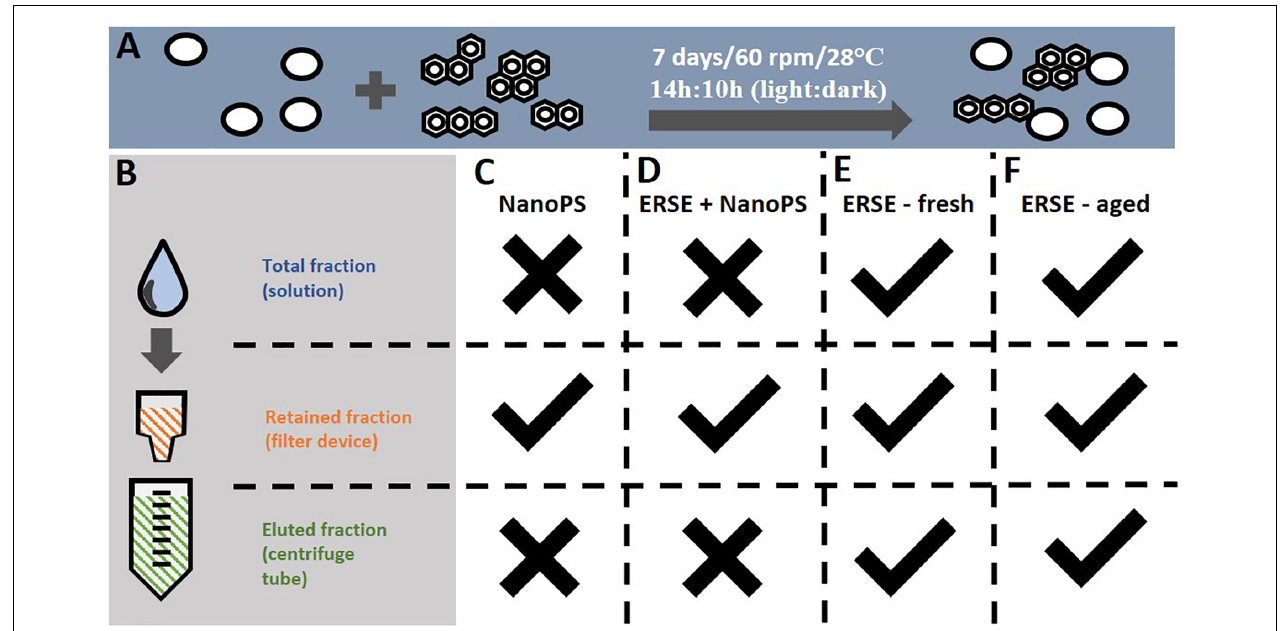
FIGURE 1 | Procedures for the sorption of PAHs to nanoplastics and the exposure groups analyzed in this study. (A) Polystyrene nanoparticles (44 nm) were incubated at 10 ppm with a mixture of PAHs (Elizabeth River Sediment Extract, ERSE – 5% v:v) in a glass flask for 7 days at the described conditions. Incubations containing only NanoPS or ERSE were carried out in the same conditions. (B) Free PAHs unbound to nanoplastics were removed from the solution using an ultrafiltration device, followed by resuspension of the retained nanoplastics to the final concentration of 1 ppm (NanoPS and PAH-NanoPS groups). (C,D) Zebrafish embryos were exposed only to the retained fractions of the NanoPS and PAH-NanoPS solutions. For comparison, embryos were also exposed to the total (unfiltered), retained and eluted fractions of (E) fresh 5% ERSE (non-incubated) or (F) aged 5% ERSE (incubated for 7 days in the absence of nanoplastics). Checkmark indicates that the respective fraction was analyzed for toxicity while an X indicates the